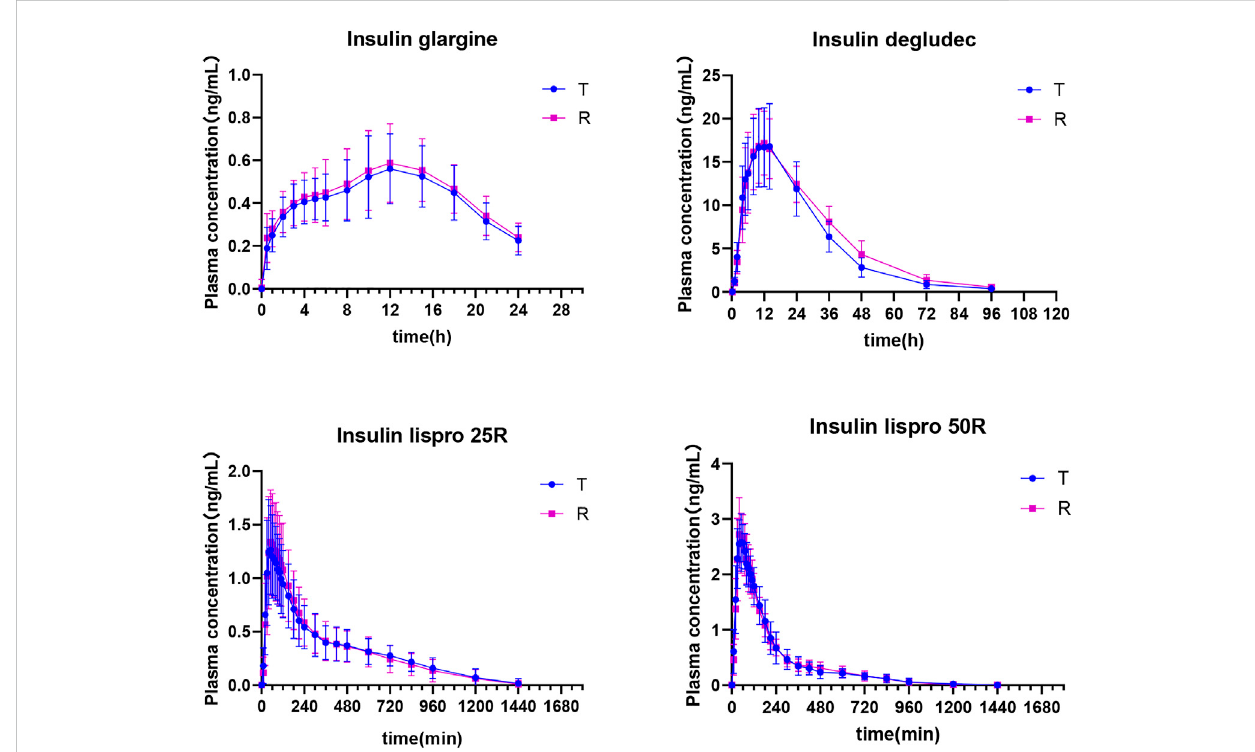
FIGURE 3 Plasma concentration versus time pro fi les after insulin biosimilar administration in healthy volunteers.